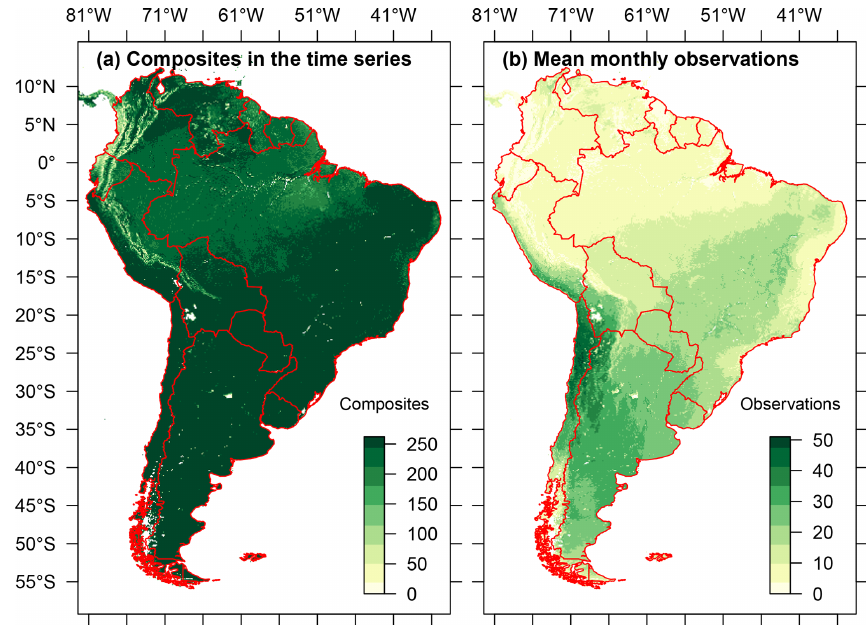
Figure 2. AnisoVeg time series availability and uncertainty over South America. (a) The number of composites in the time series representing pixel availability. The maximum number of composites in the time series is 262 for the period between March 2000 and December 2021. (b) Mean number of daily observations within a month used to create the monthly composites as a proxy for uncertainty. The maximum daily observations in a composite is 60 (twice a day every day for a